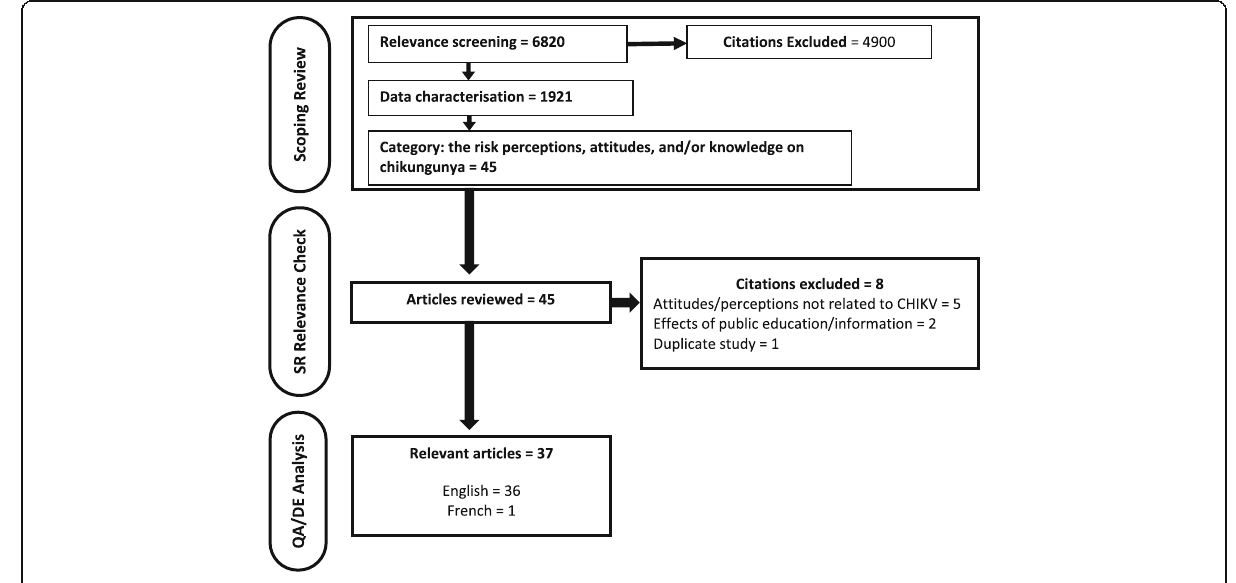
Fig. 1 PRISMA flow diagram of articles through the systematic review